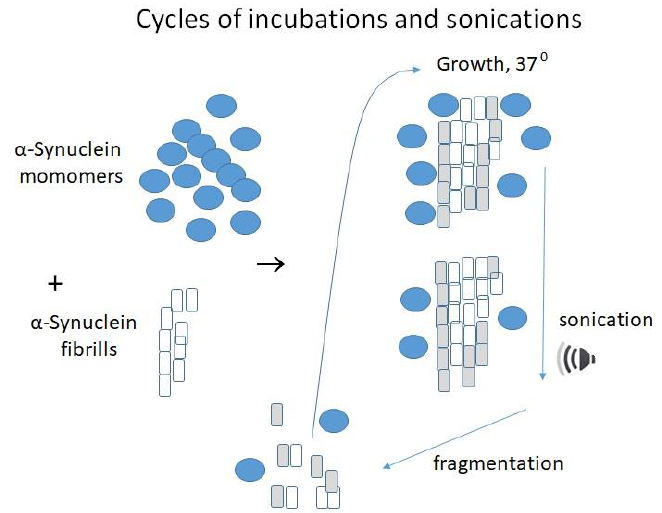
Figure 1. The PMCA is a cyclic reaction, combining the growing and multiplication of the template units. A small amount of fibrillar α -synuclein is incubated with an excess of monomeric α -synuclein. After some conversion occurs, the mixture is blasted with ultrasound, breaking it down into smaller pieces. As a result of this step, the amount of fibrillar protein available to cause further conversions is rapidly increased. By repeating the cycle, the mass of monomeric α -synuclein is quickly changed into the fibrillar protein. The method may be automated, causing a significant increase in the efficiency of amplification.